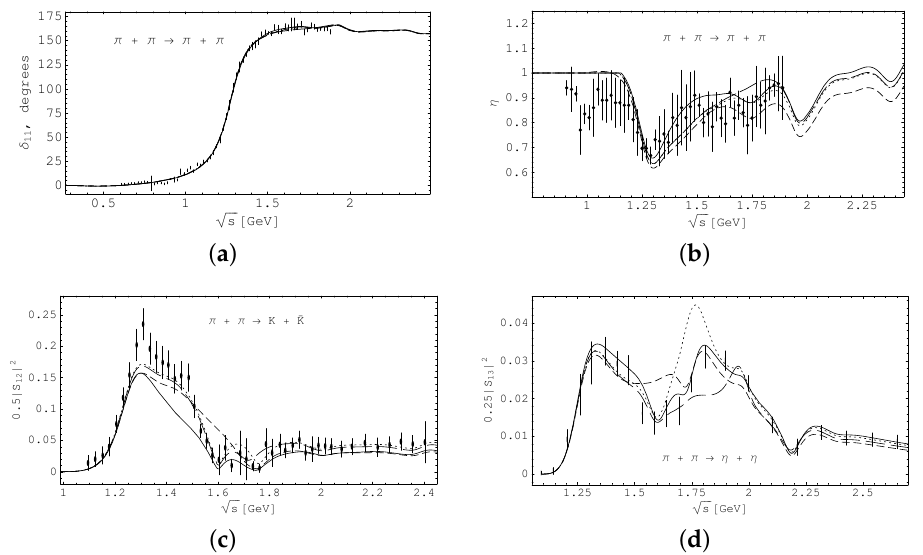
Figure 5. Scattering properties of the ππ → ππ , K ¯ K , ηη processes for four scenarios: (1) f 2 ( 1450.5 ) and f 2 ( 1534.7 ) states are excluded (solid line); (2) f 2 ( 1534.7 ) and f 2 ( 1719.8 ) states are excluded (dotted line); (3) f 2 ( 1534.7 ) and f 2 ( 1601.5 ) states are excluded (short-dashed line); (4) f 2 ( 1534.7 ) and f 2 ( 1760 ) states are excluded (long-dashed line). The experimental data are from Refs. [31,32]. ( a ): Phase shift and in the D -wave ππ -scattering. ( b ): Modulus of the S -matrix element in the D - wave ππ -scattering. ( c ): Squared moduli of the S -matrix element in the D -wave ππ → K ¯ K process. ( d ): Squared moduli of the S -matrix element in the D -wave ππ → ηη process.